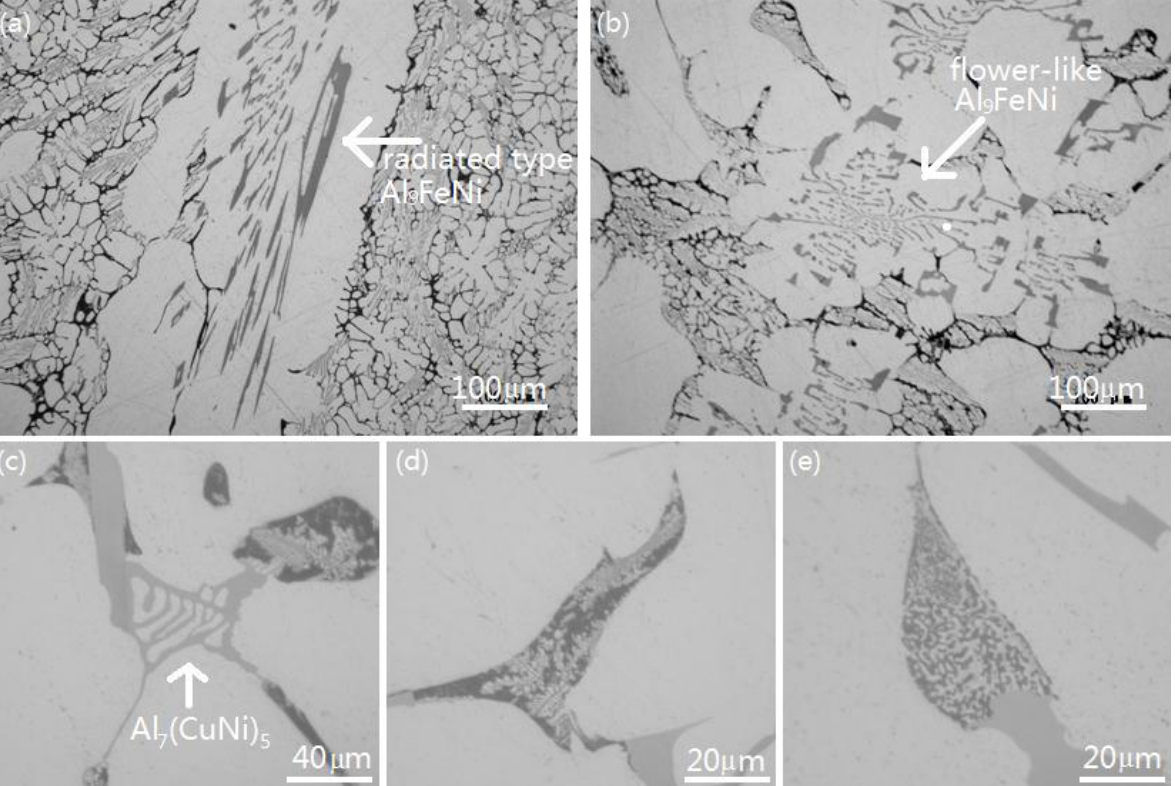
Figure 6. The microstructures after interrupted quenching at different temperatures: